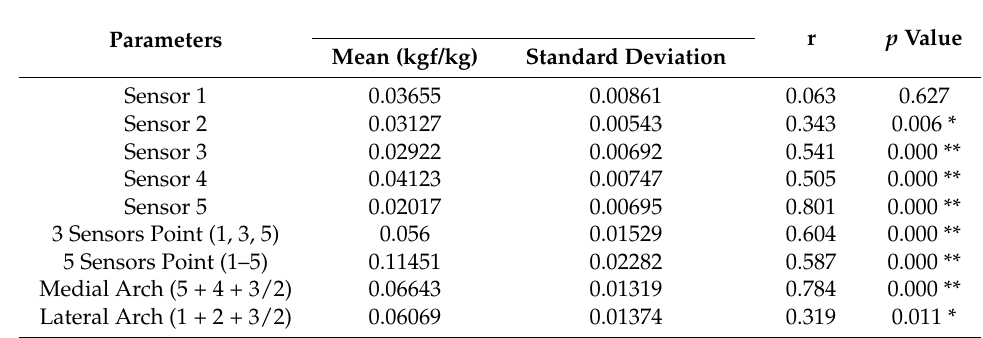
Table 4. Pearson correlation between the force sensor standing value and the ink-type AI value in the dynamic test.